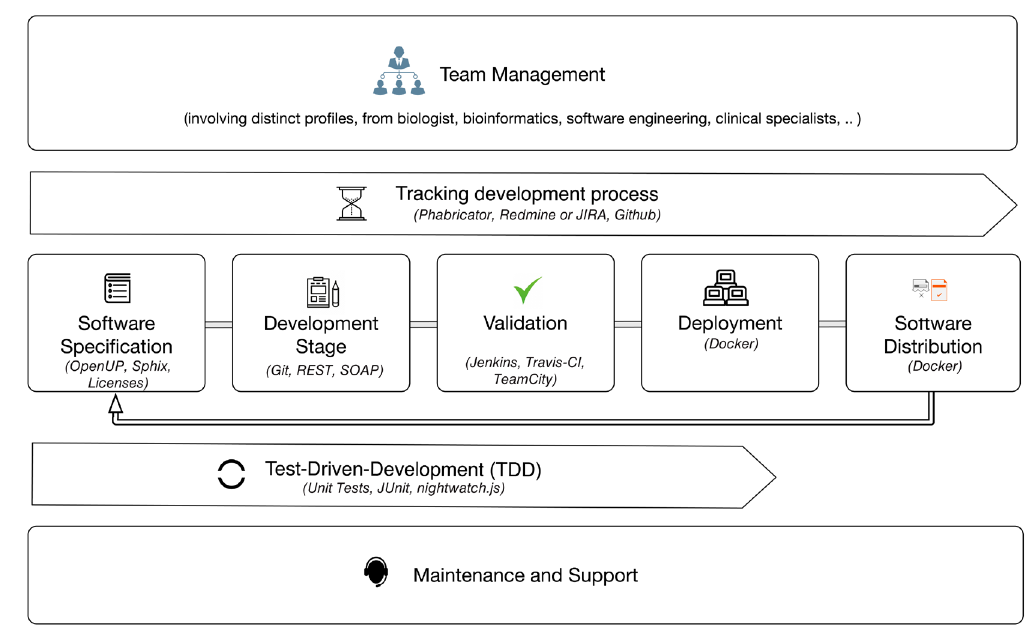
Figure 1. Software development process: including the several stages of the